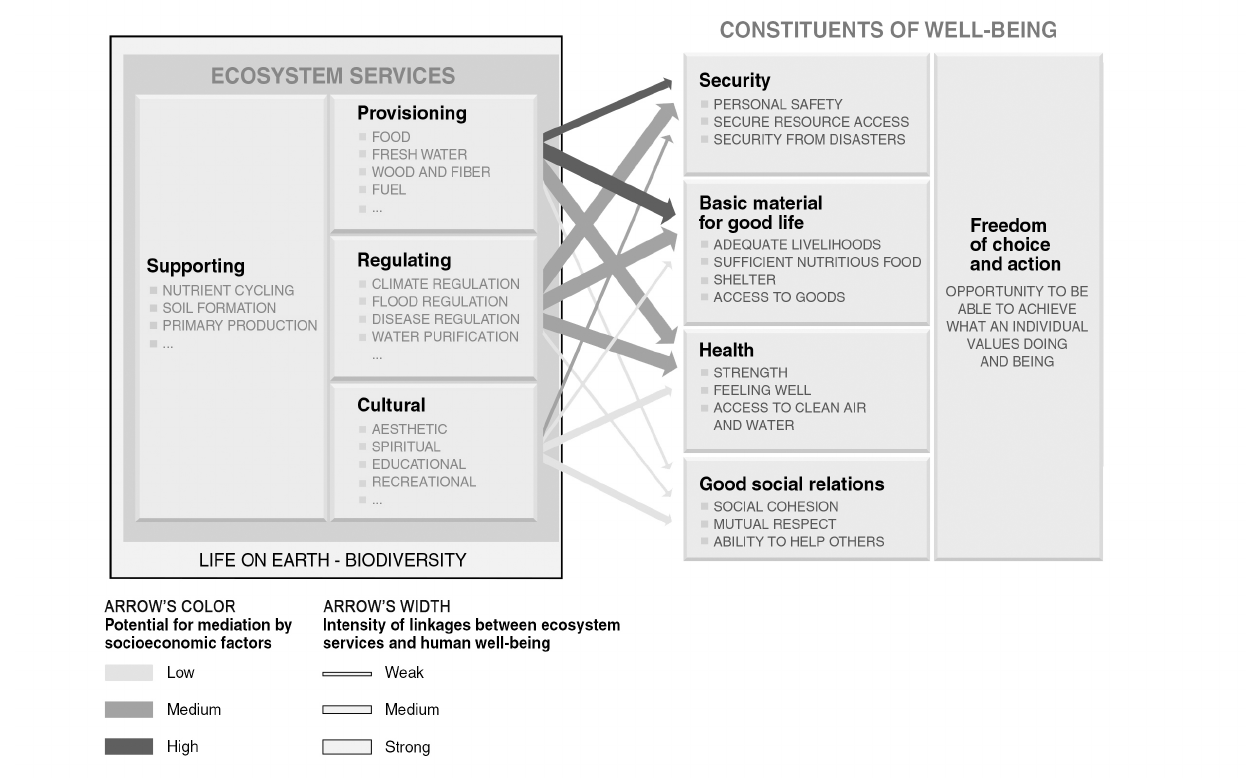
Figure 2. Linkages between ecosystem services and human well-being. The strength of linkages between categories of ecosystem services and components of human well-being and indications of the extent to which it is possible for socioeconomic factors to mediate the linkage. The strength of the linkages and the potential for mediation differ in different ecosystems and regions. (Source: